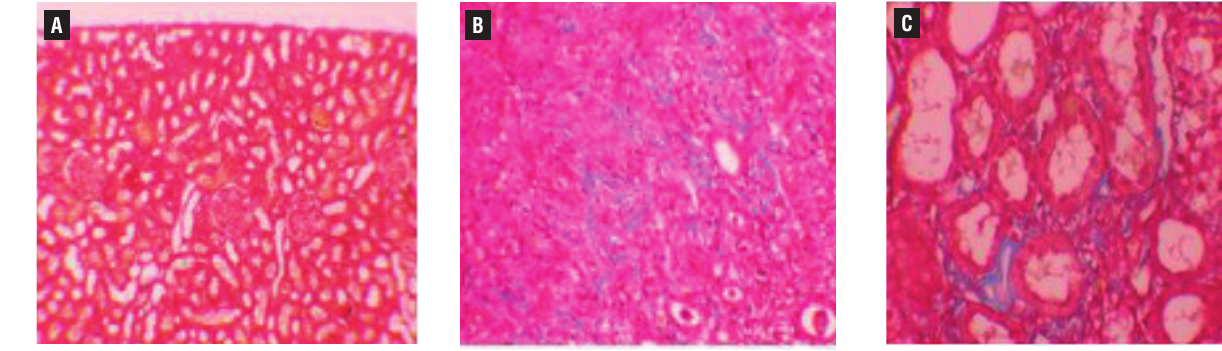
figure 3 - A) normal kidney morphology in a sham group, group (masson & trichrome x200). b) severe fibrosis was observed in the peritubular interstitium of the uuO, group (masson & trichrome x400). c) mild fibrosis was reduced in the nahs-treated group (masson & trichrome